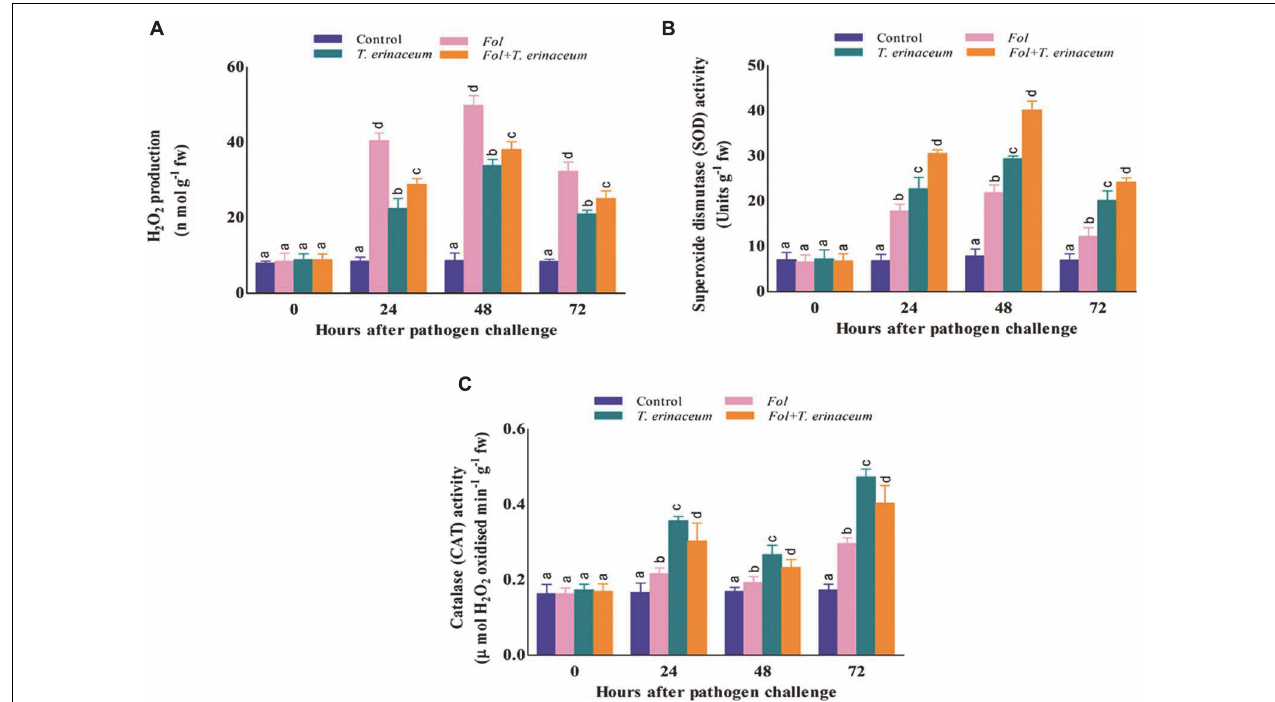
FIGURE 9 | The comparative evaluation of biochemical activities of T. erinaceum bioprimed and unprimed samples under the Fol challenged conditions. (A) The H